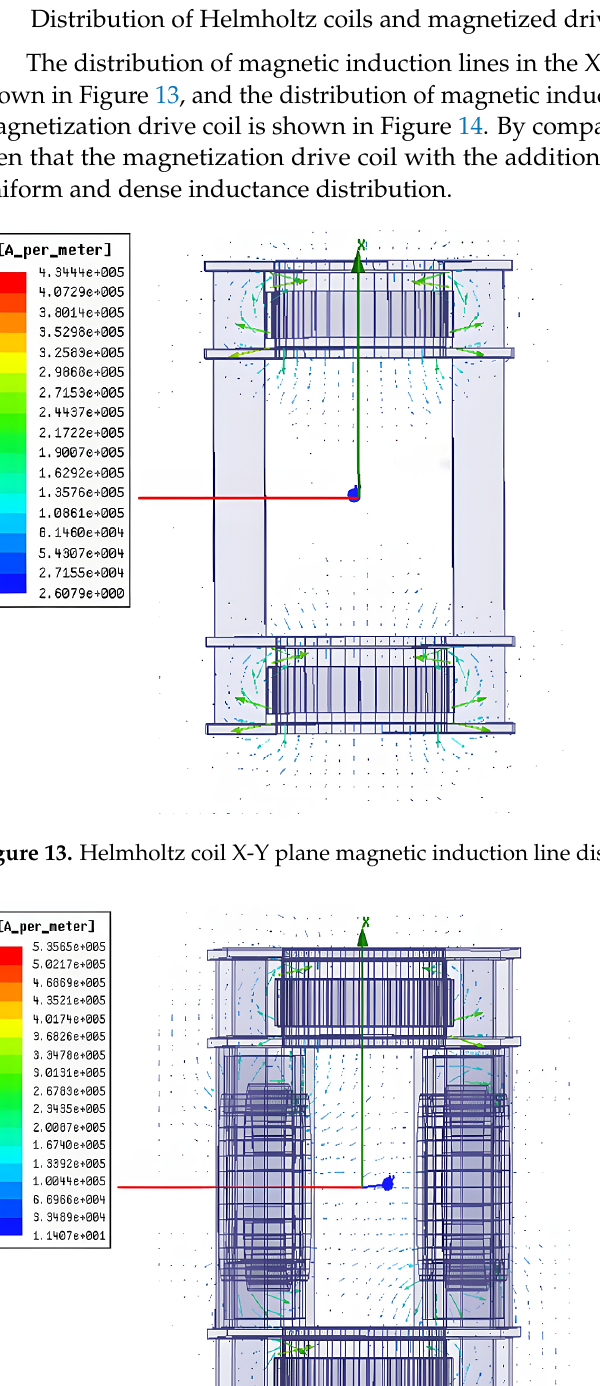
Figure 12. Comparison of the magnetic induction intensity characteristic curves of magnetized drive coils and Single-Axis Helmholtz Coils Only.